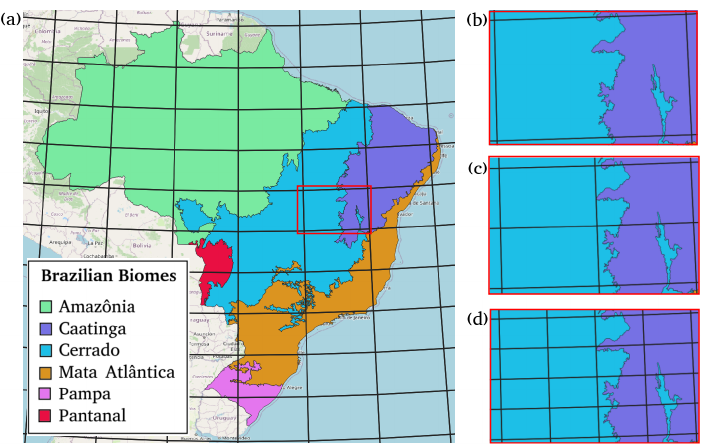
Figure 3. Hierarchical BDC tiling system showing BDC_LG overlayed on Brazilian Biomes ( a ), illustrating that one BDC_LG tile ( b ) contains four BDC_MD tiles ( c ) and that BDC_MD contains four BDC_SM tiles ( d